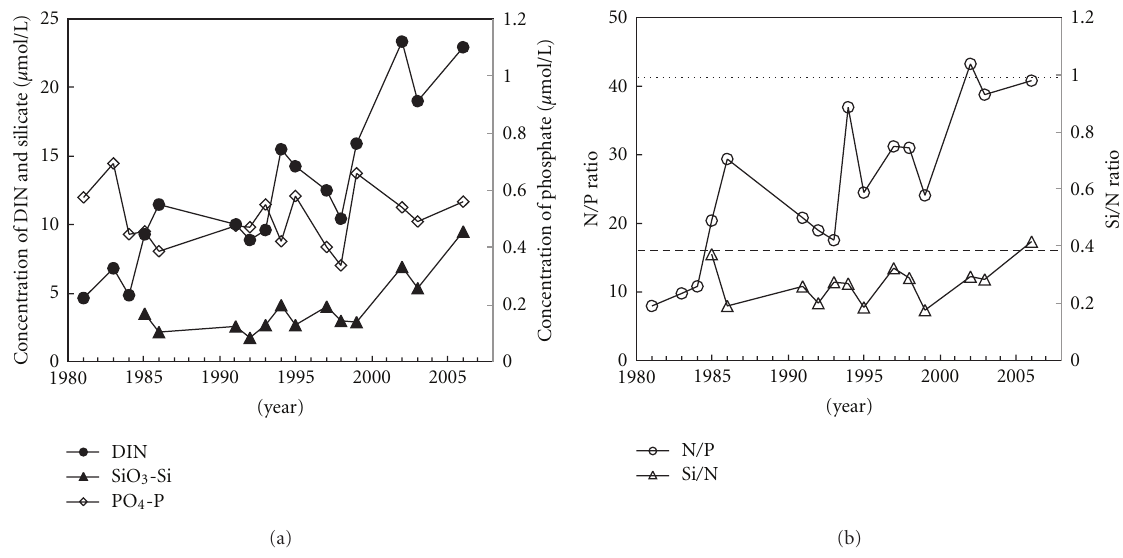
Figure 2: Long-term variations in nutrient concentrations ( µ mol L − 1 ) (a) and their ratios (b) in Jiaozhou Bay (the dashed line indicates Redfield value for N/P, the dotted line for